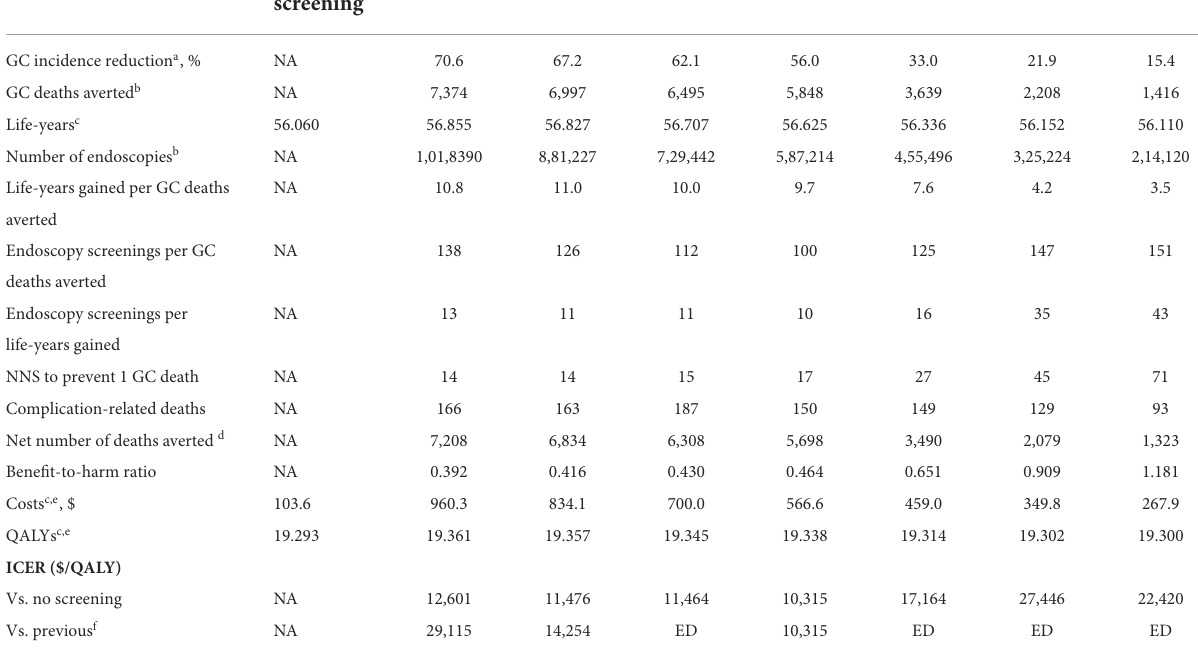
TABLE 1 Clinical and cost-effectiveness